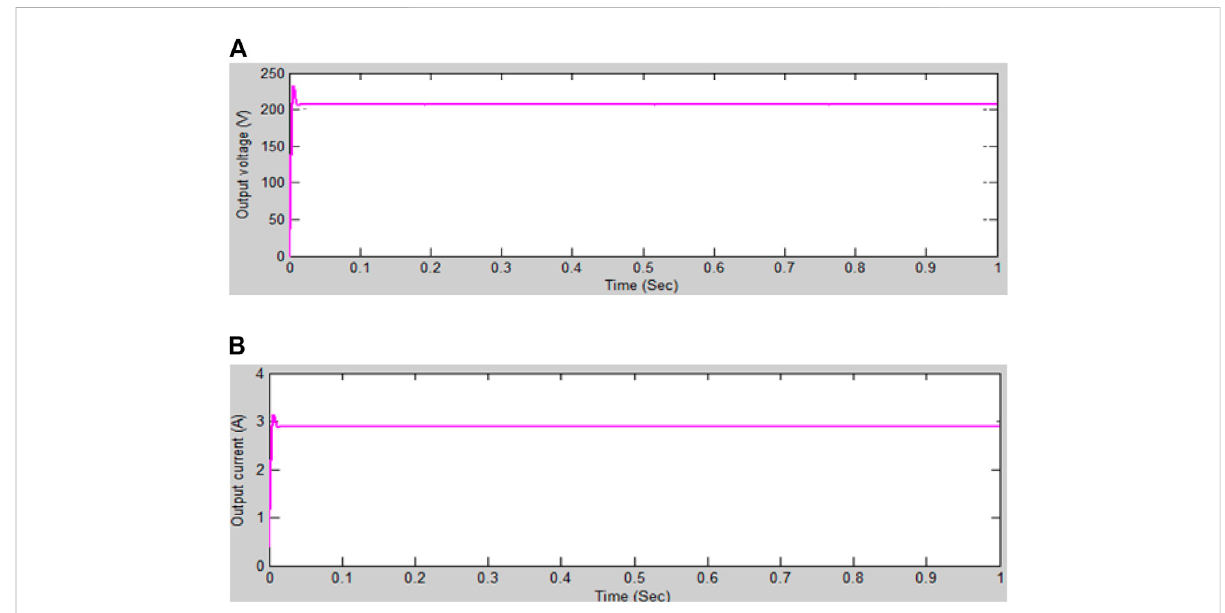
FIGURE 11 (A) OutputvoltageofDISO-NIconverterfedfromSolarPVsystemandPEMfuelcell. (B) OutputcurrentofDISO-NIconverterfedfromSolarPV system and PEM fuel cell.